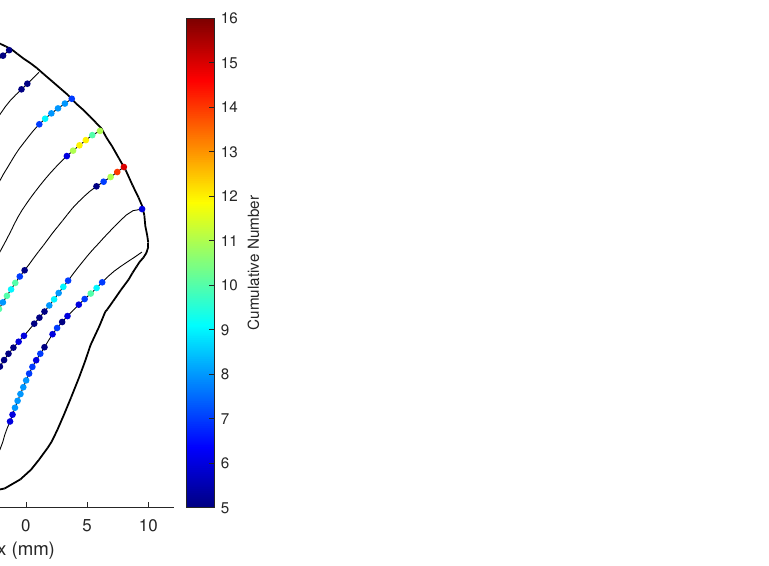
Figure 19. Cumulative numbers for being the optimal location when measurement noise variance is large: ω (cid:118) = 5, ω Υ = 100, and r = 30. When the noise variance of the shear and bending strain measurements diminishes Figure 20. In this situation, the numbers for the best locations at the center and upper part of the wing